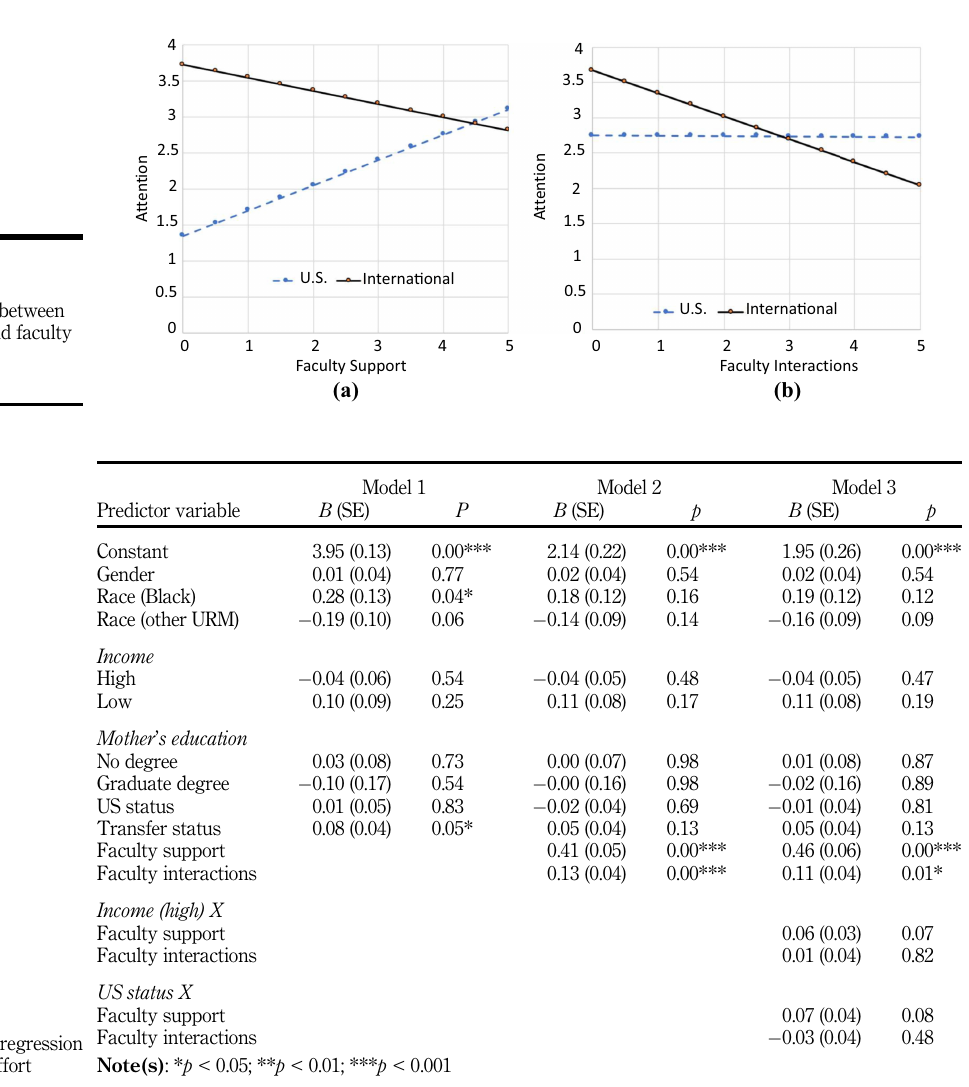
Table 6. Hierarchical regression models for